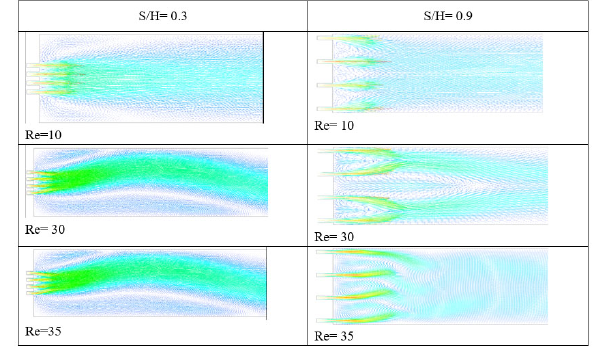
Figure 9: Velocity vector of characteristic flows for S/H = 0.3, 0.9 in four jets